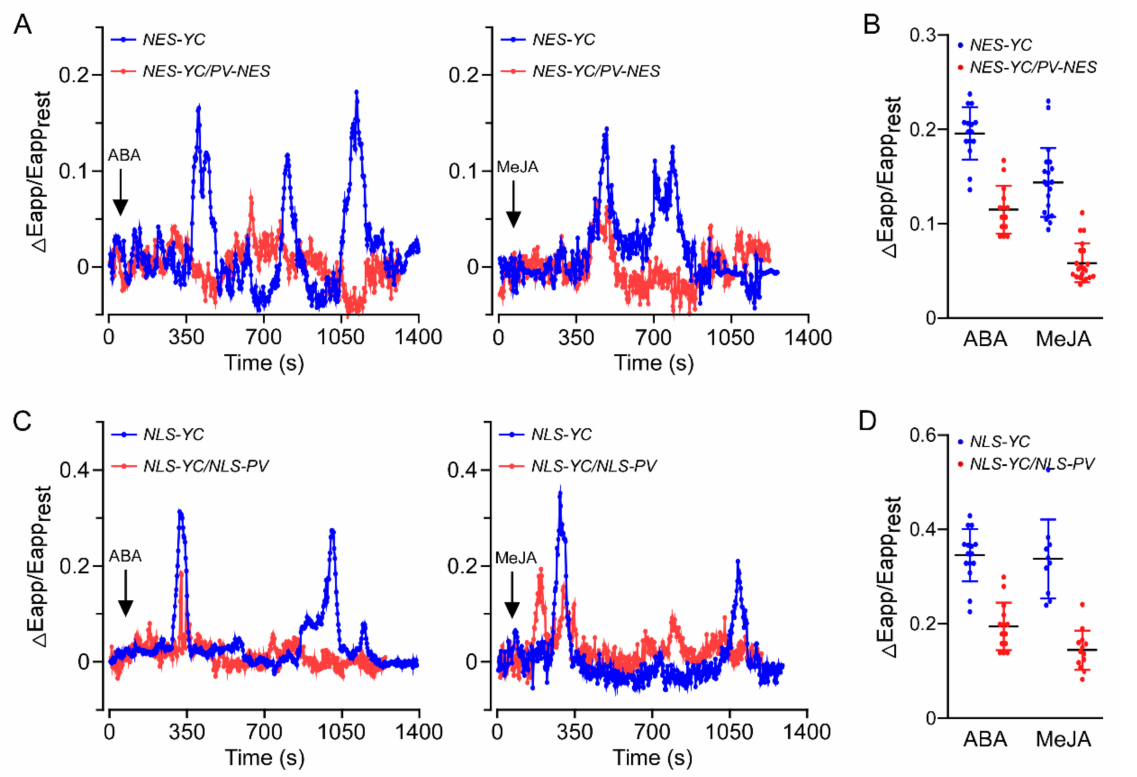
Figure 1. Impaired [Ca 2+ ] cyt and [Ca 2+ ] nuc increases in responses to ABA and MeJA treatment in root cells of PV-NES and PV- NLS transgenic A. thaliana lines, respectively. ( A , B ) Changes in [Ca 2+ ]